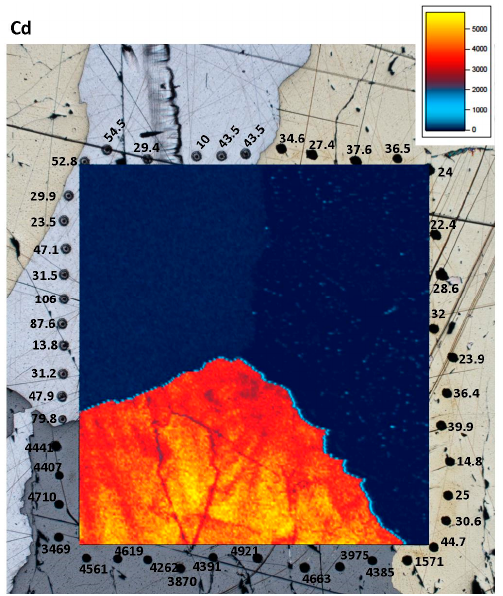
Figure 4. Comparison between quantitative LA ‐ ICP ‐ MS trace element maps (Ag, Sb and Cd, ppm scales) of a galena (light grey)–sphalerite (dark grey)–chalcopyrite (yellow) assemblage with spot analyses (in ppm) immediately adjacent to the mapped area. An average value for sulfur was used as the internal standard to accommodate the three distinct minerals.